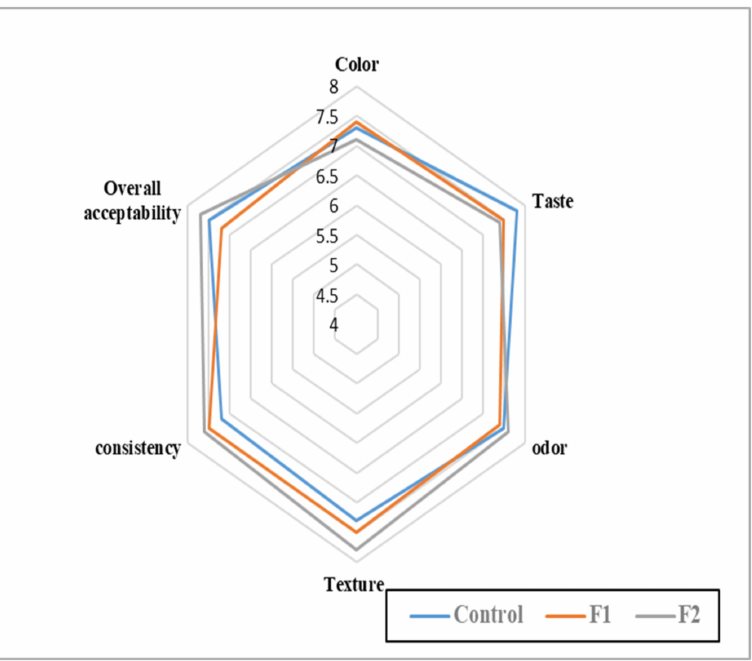
Figure 4. Sensory evaluation of the control and fortified samples of sesame tahini. F1: Sesame tahini contains 0.5% Agaricus blazei lyophilized powder; F2: sesame tahini contains 1.0% Agaricus blazei lyophilized powder; ND: not detectable; sesame tahini: tahini manufactured with just sesame